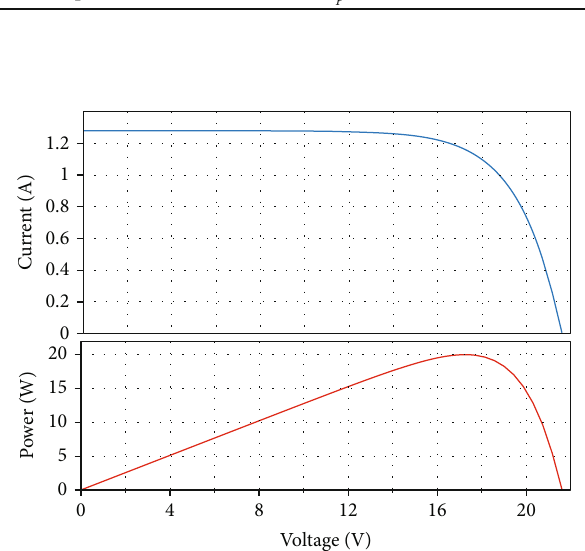
Figure 5: I-V and P-V characteristics of the PV panel at 1000W/m 2 , T = 25 ° C .